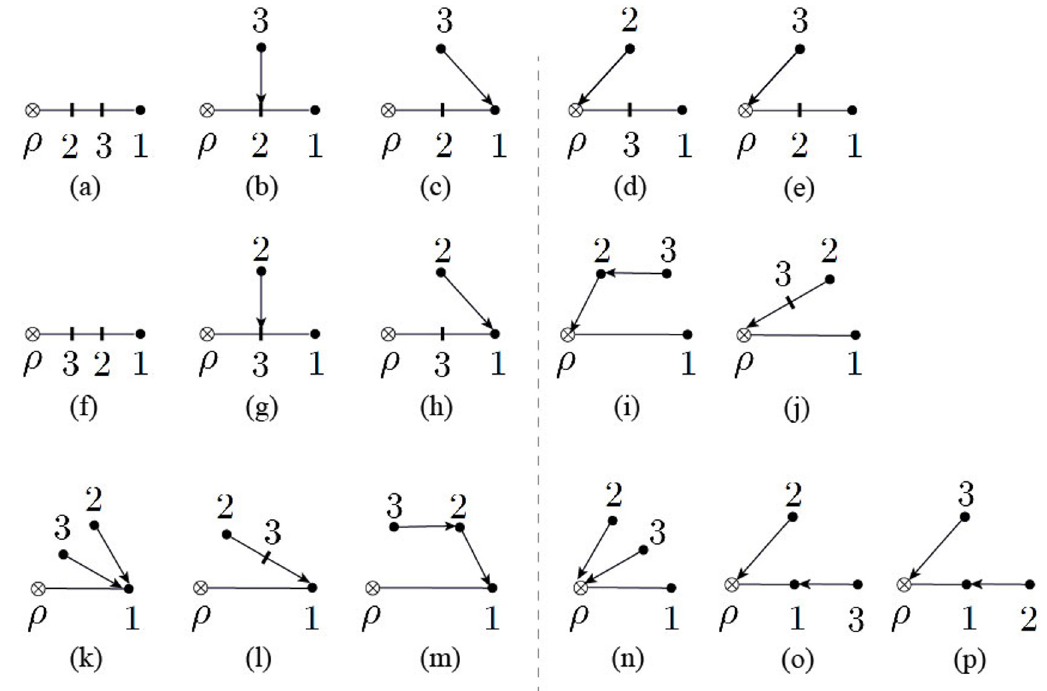
Figure 5 . Type-B graphs with three on-shell nodes.